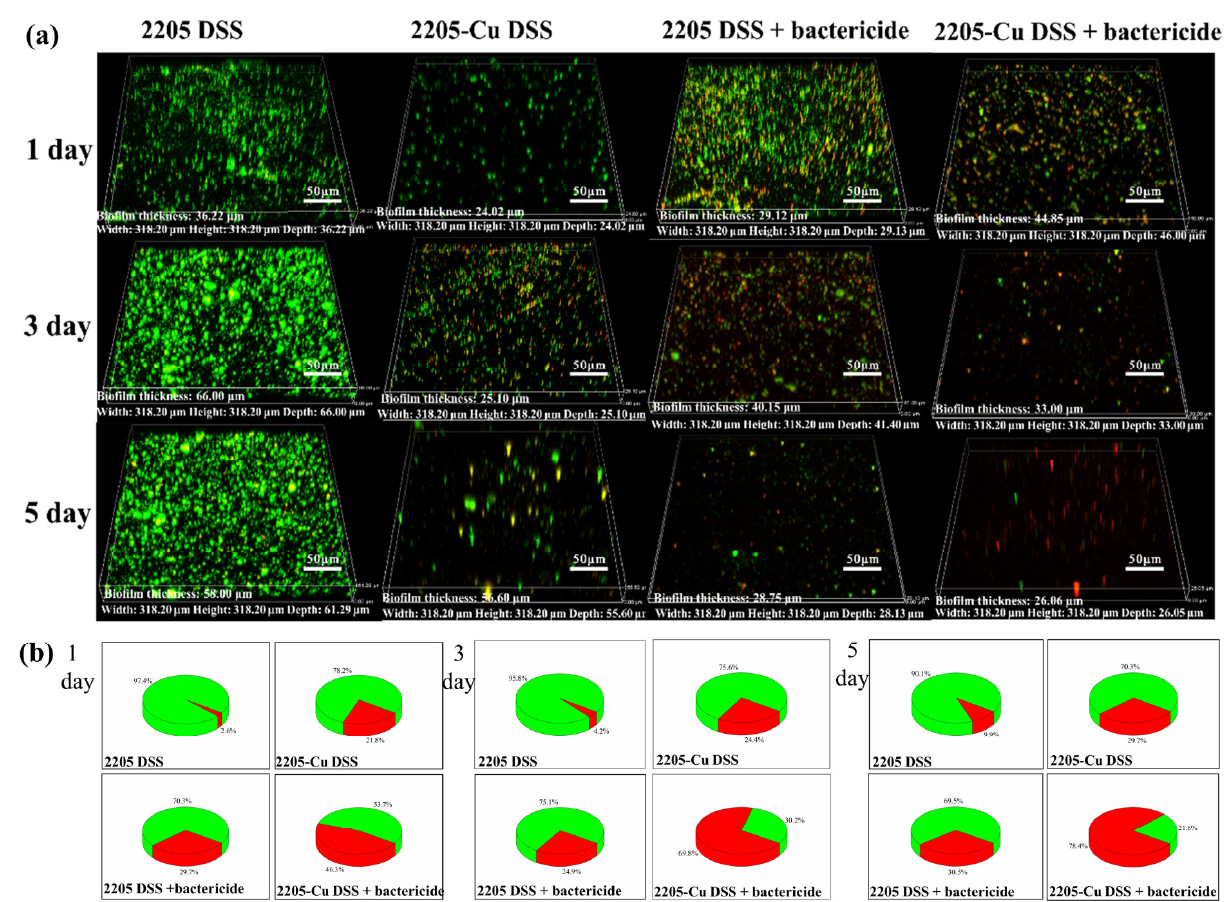
Figure 3. ( a ) CLSM images (3D) of the biofilms on 2205 DSS and 2205-Cu DSS after the 1-, 3-, and 5-day incubations. The bactericide is benzalkonium bromide. ( b ) The proportion of live/dead sessile cells. Red represents dead cells; green represents live cells.